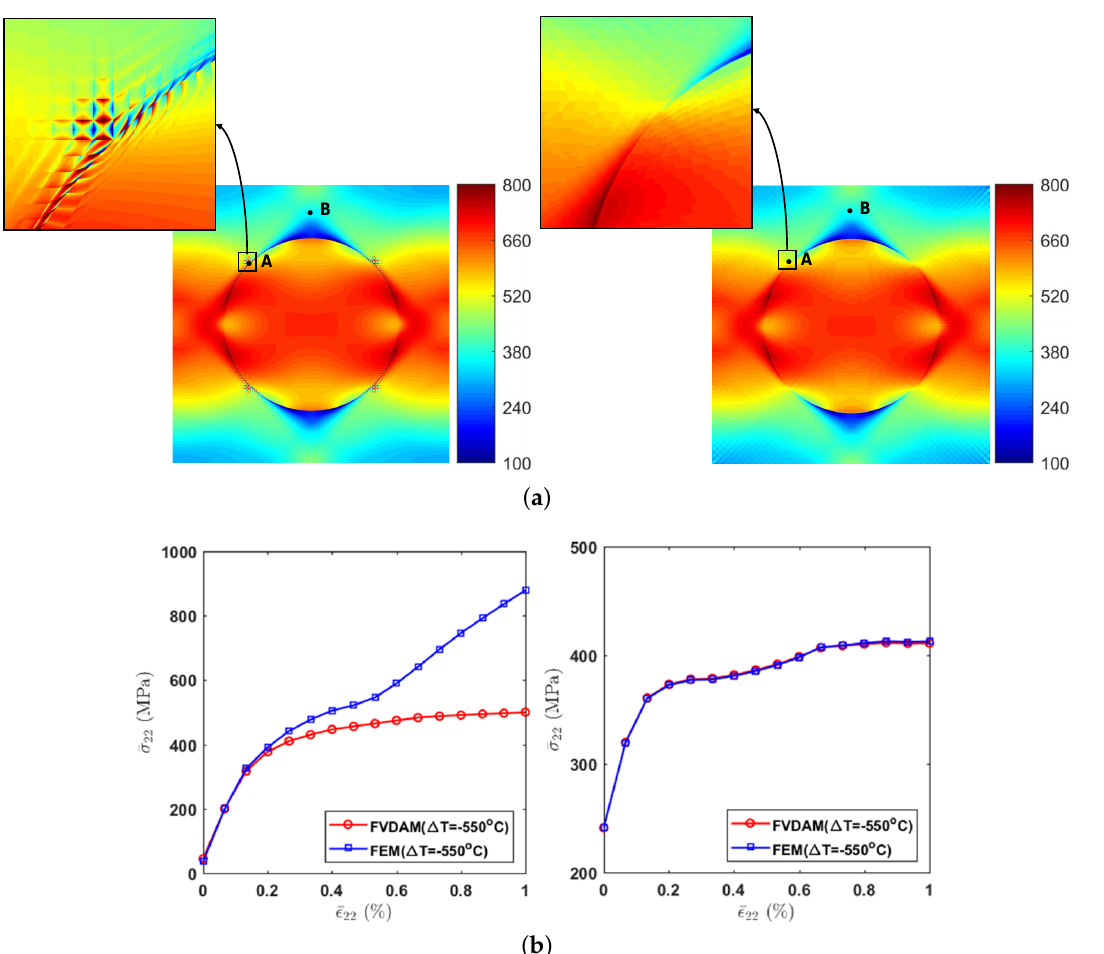
Figure 7. Comparison of the convergence using the finite-element method (FEM) and the finite-volume direct averaging micromechanics (FVDAM). ( a ) Comparison of the transverse thermo-mechanical tensile local field in the large stress concentration area: FEM (left); FVDAM (right); ( b ) Comparison of the transverse thermo-mechanical tensile response of the composite at point A (left) and point B